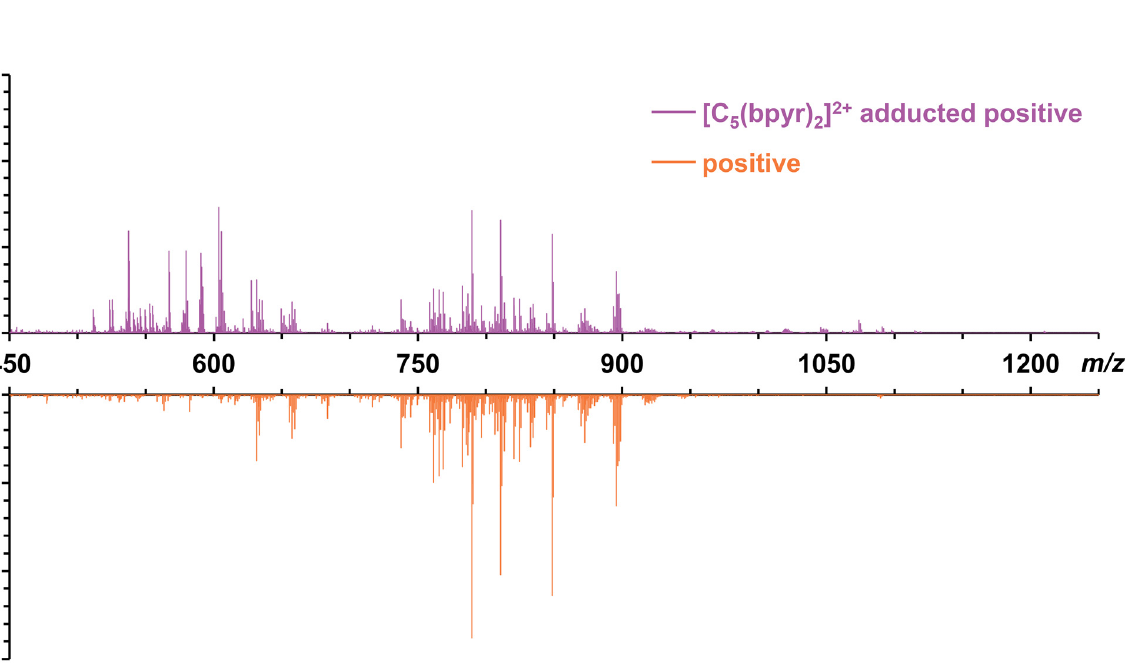
Figure 2. Comparison of mass spectra from rat liver sections between [C 5 (bpyr) 2 ] 2+ adducted positive ionization mode (purple, top) and positive ionization mode (orange, bottom); ( A ). Full mass spectrum at 450–1250 m / z ; ( B , C ). Zoomed-in mass spectra with labeled m / z related to adducts with [C 5 (bpyr) 2 ] 2+ .